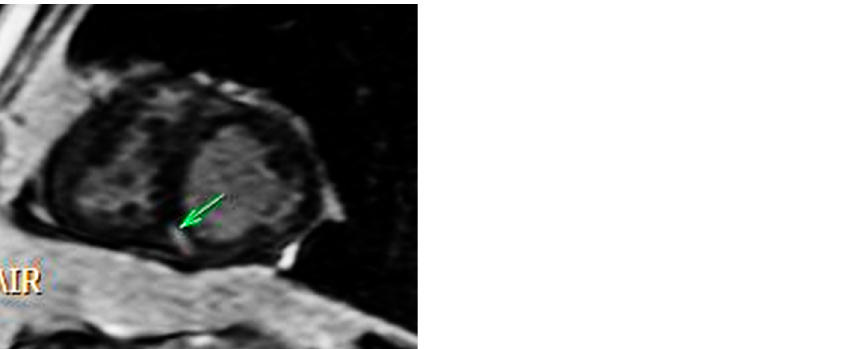
Figure 3. LGE: nodular contrast enhancement at the level of the posterior septal insertion of the RV free wall.